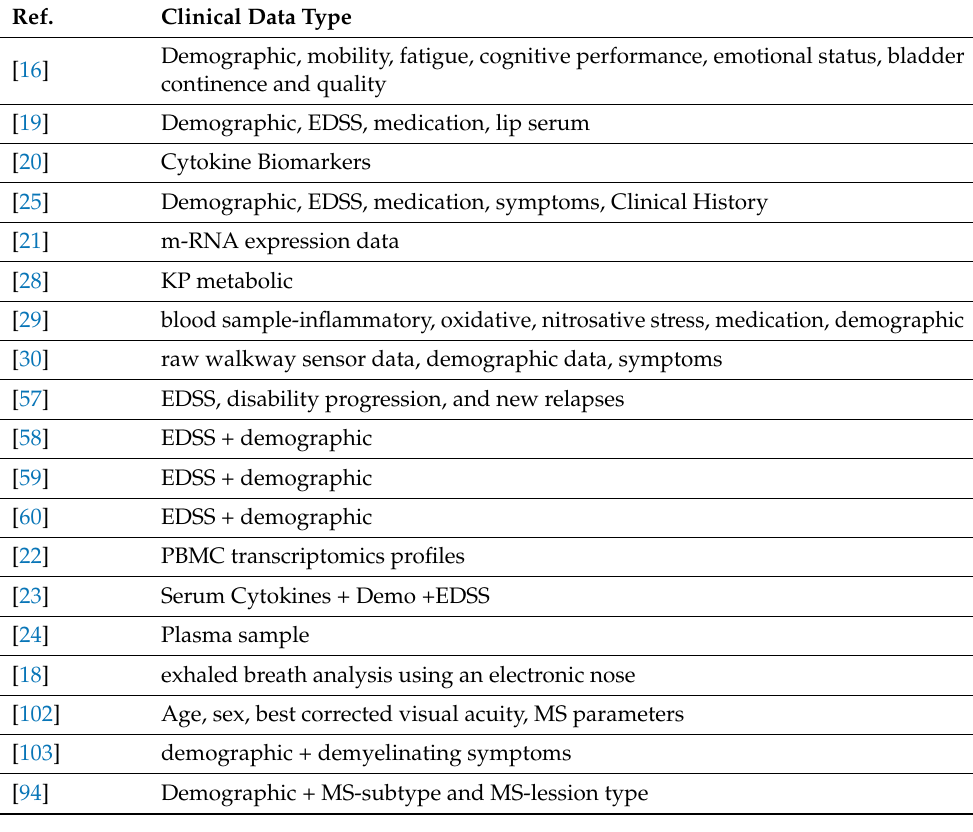
Table 5. Summary of the previous studies that used clinical data.